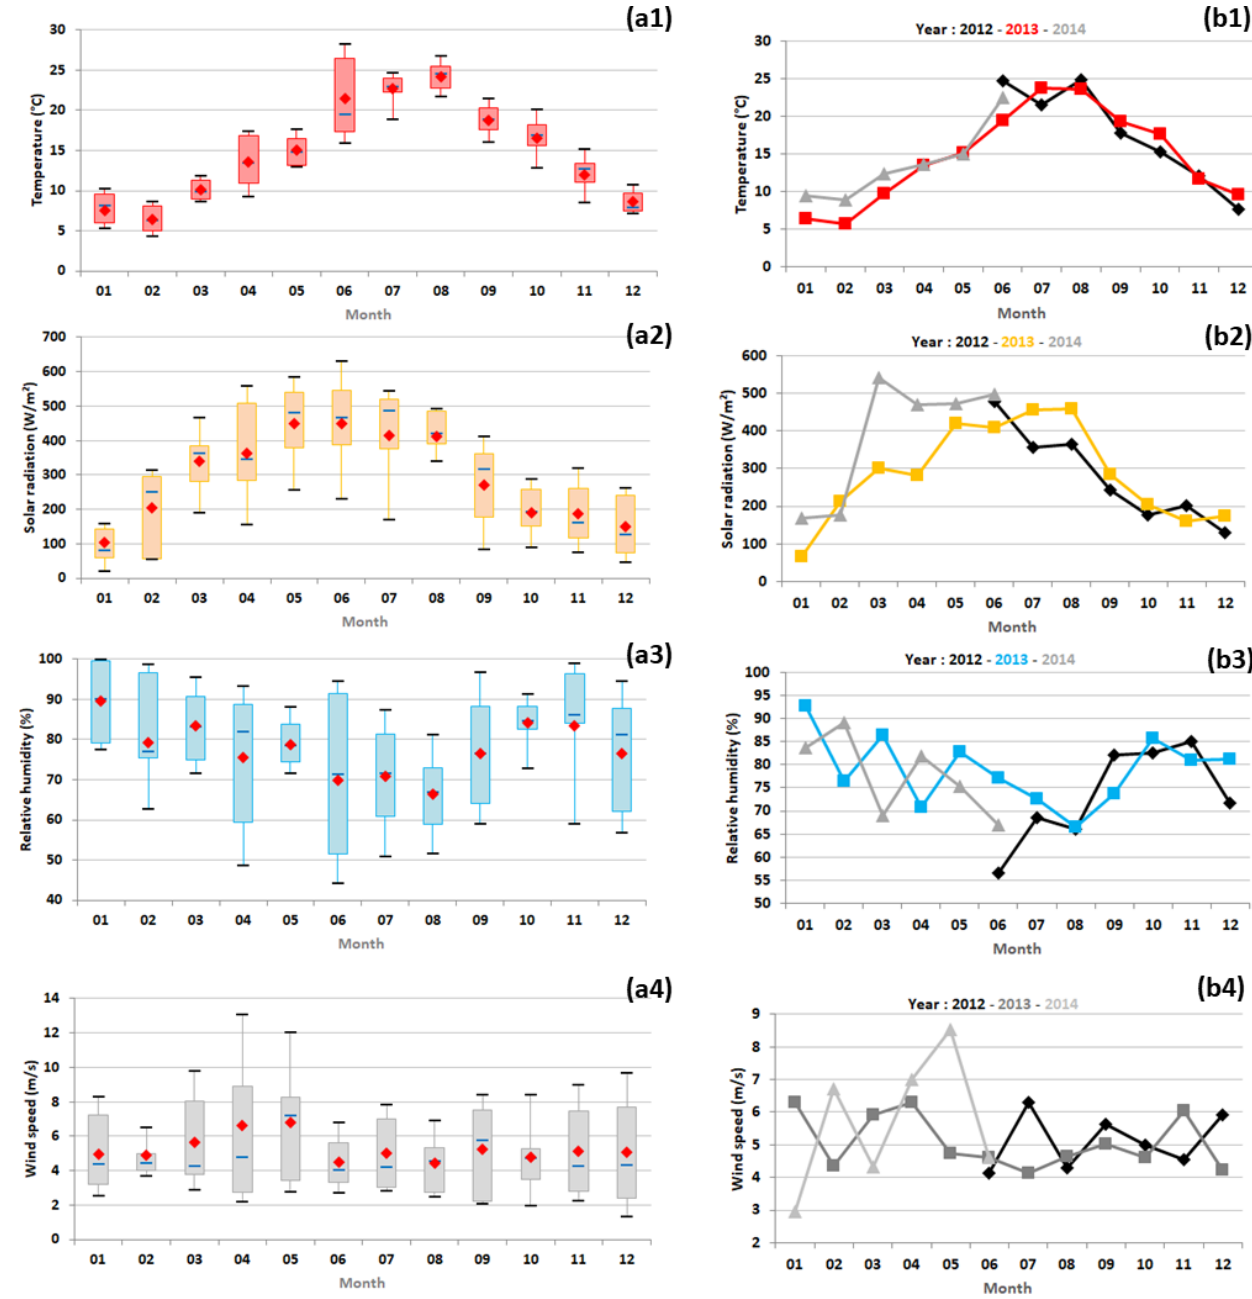
Figure 3. (a) Monthly variations in meteorological parameters (temperature expressed in ◦ C, global solar radiation in Wm − 2 , relative humidity in % and wind speed in ms − 1 ) represented by box plots; the blue solid line, the red marker, and the box represent the median, the mean, and the interquartile range of the values, respectively. The bottom and top of the box depict the first and third quartiles and the ends of the whiskers correspond to the first and ninth deciles. (b) Their monthly average concentrations as a function of the year. Note that meteorological parameter data used in this study were restricted to periods when VOC measurements were